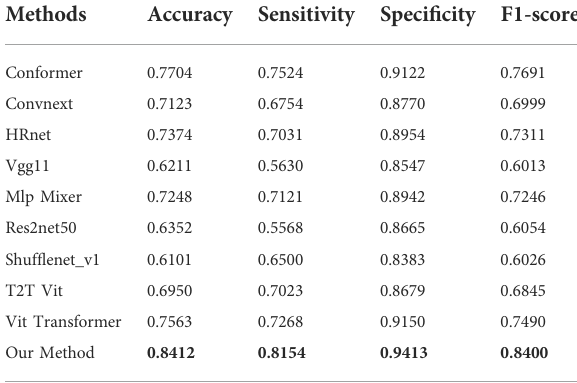
TABLE 3 Comparing the existing methods of multi-classi fi cation for diabetic retinopathy.